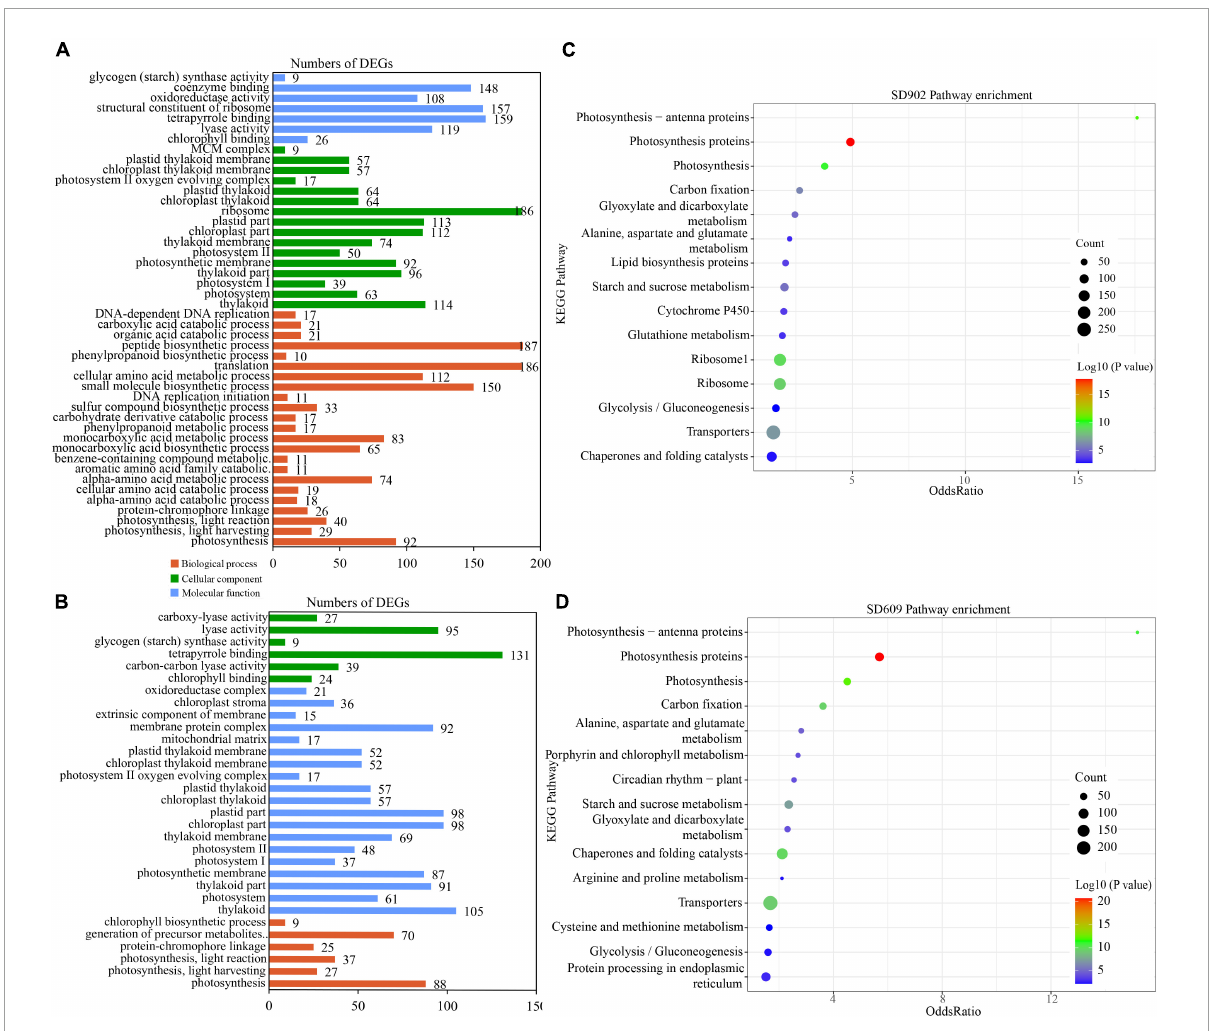
FIGURE3 Gene Ontology (GO) and Kyoto Encyclopedia of Genes and Genome (KEGG) enrichment of differentially expressed genes (DEGs) between SD902 and SD609. (A,B) GO classification enrichment between the two genotypes. (C,D) Top 15 KEGG enrichment pathways of the two genotypes based on annotation